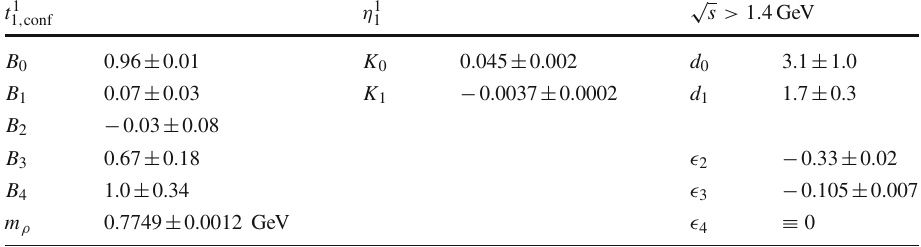
Table 10 Fit parameters of the global parameterization for the P -wave solution III